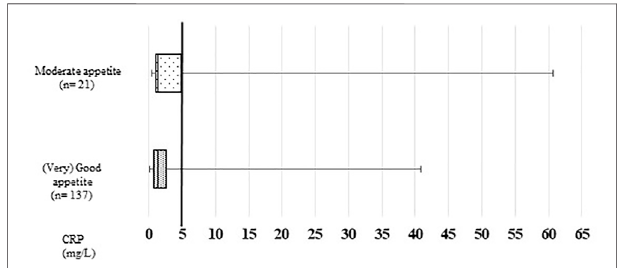
FIGURE 1 | Participants ’ CRP (C-reactive protein) levels according to appetite. Comparison between the groups, Mann-Whitney-U-test, p = 0.296.